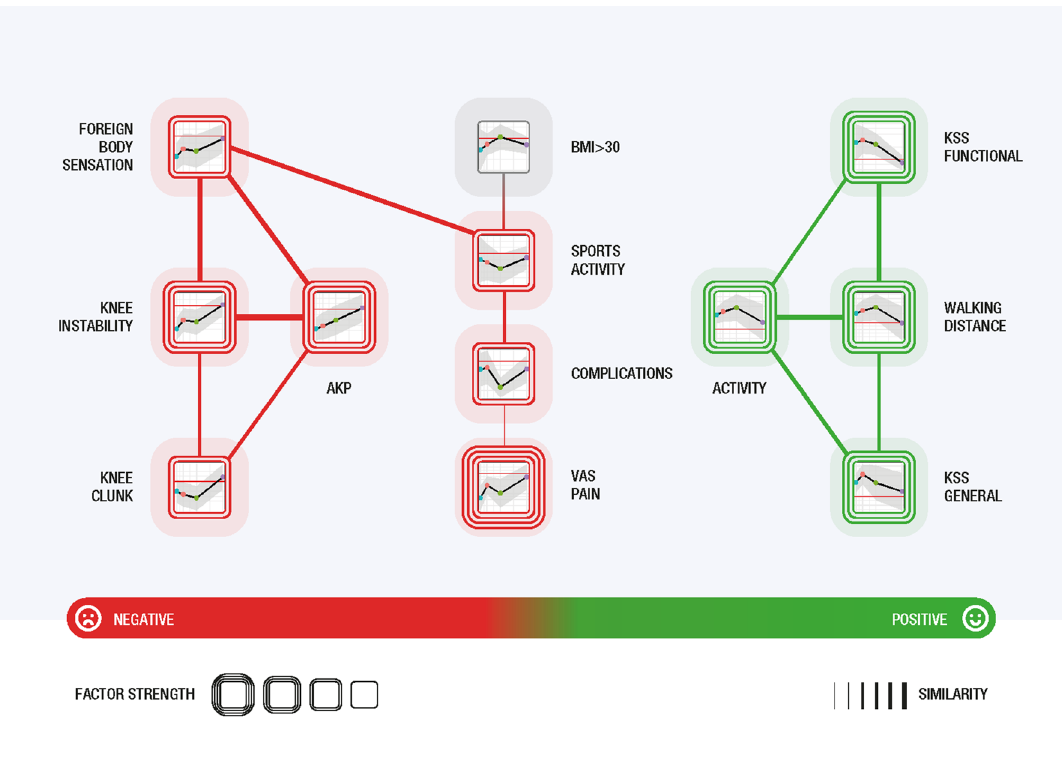
Figure 3. Odds-ratio network for combinations of postoperative factors contributing to satisfaction 2 years after TKA in women. The right cluster (green) combines factors associated with satisfaction, and the left cluster (red) combines factors associated with not being fully satisfied. The size of a network vertex corresponds to its similarity to the neighbouring vertices (=